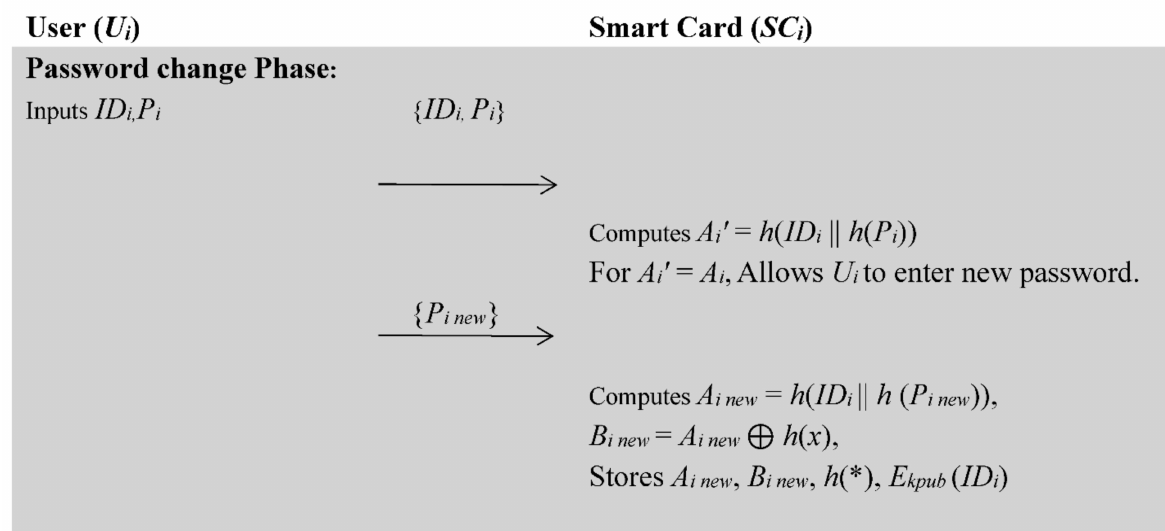
Figure 3. Password Change Phase.